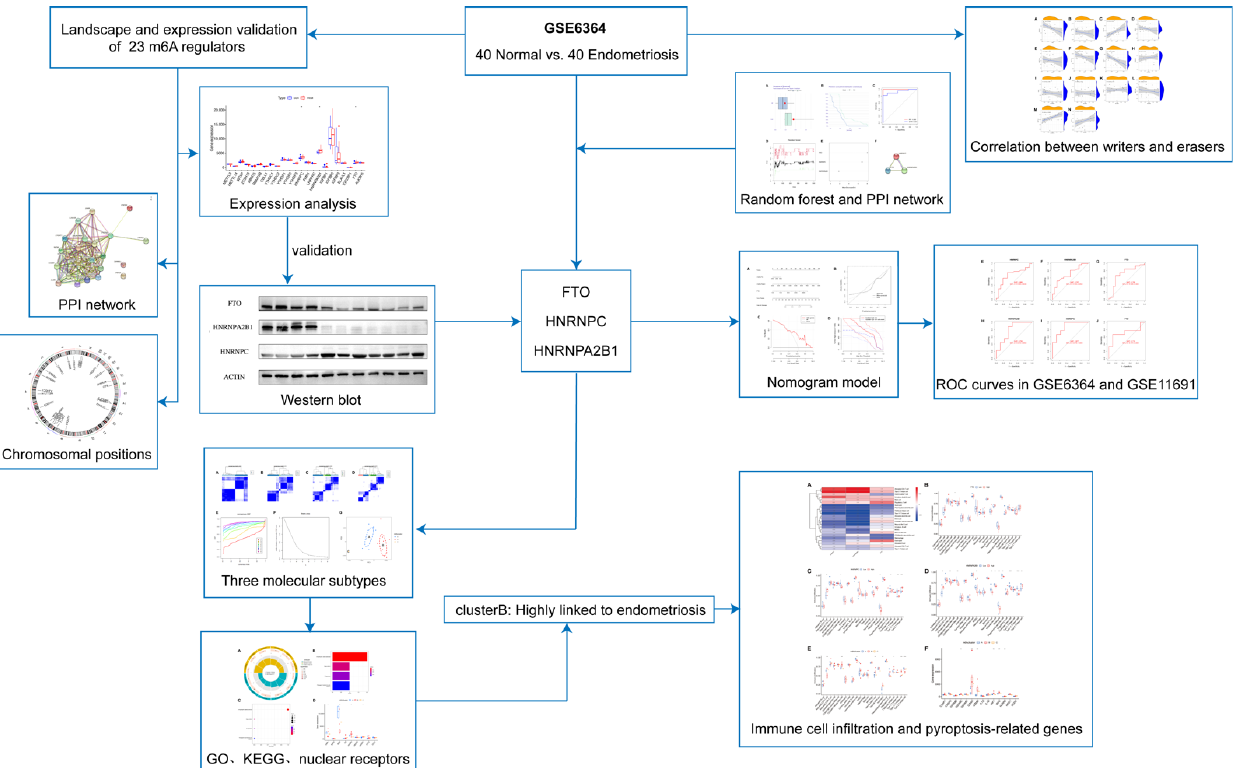
Figure 1. The work flow of our study. The work flow showed how we designed and conducted our